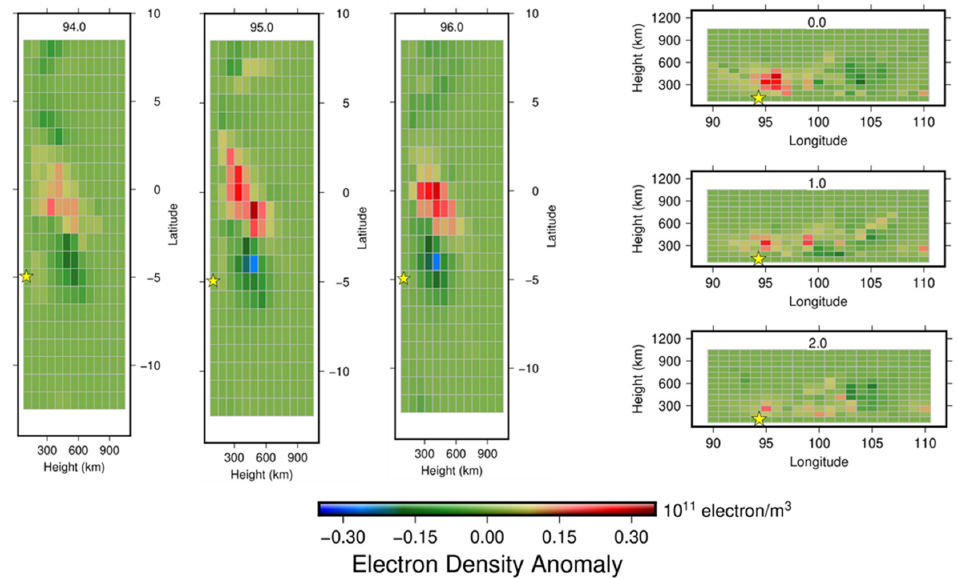
Figure 9. The tomographic 3D model profile is viewed from the longitude and latitude point of view.